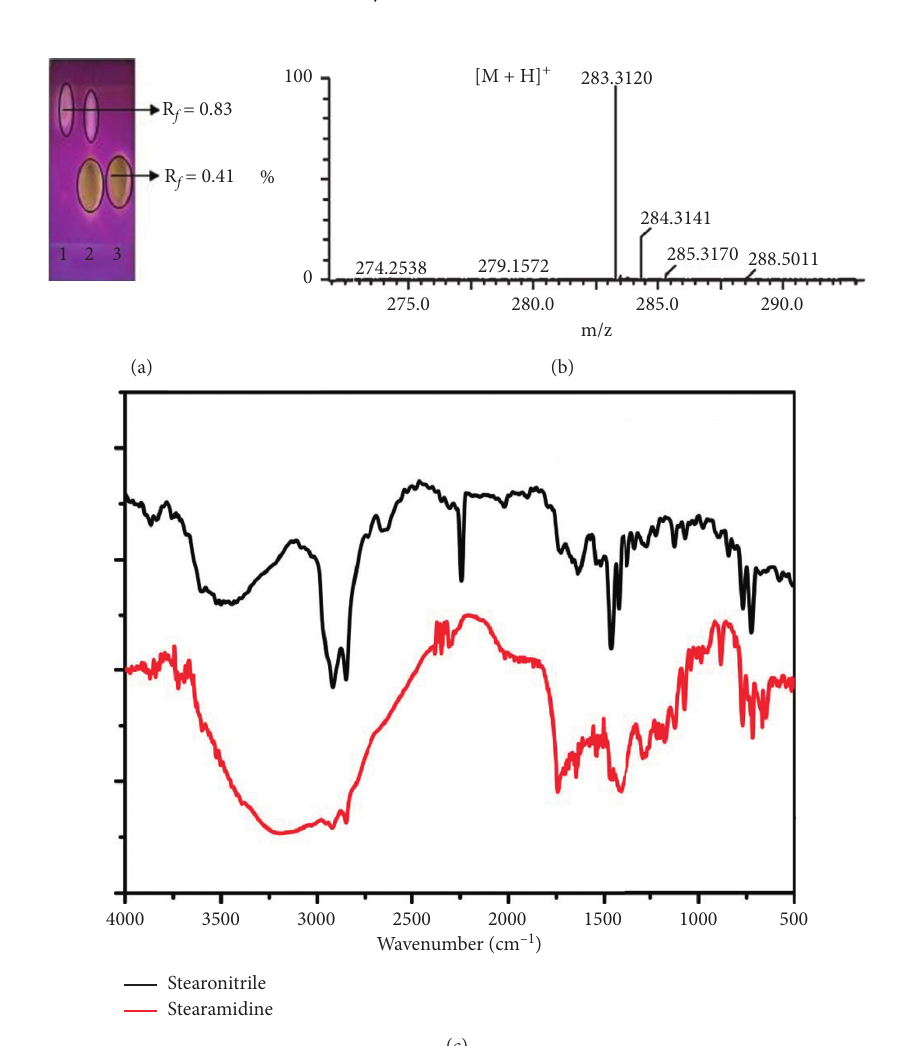
Figure 1: (a) TLC of reaction crude (1 � precursor, 2 � cospot, and 3 � reaction crude). (b) ESI MS of stearamidine. (c) FTIR spectra of stearonitrile (black) and stearamidine